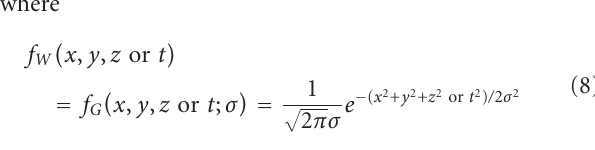
Figure 11: Scoring method for combining pixel-based output responses from the trained MTANN into a single score for each ROI.